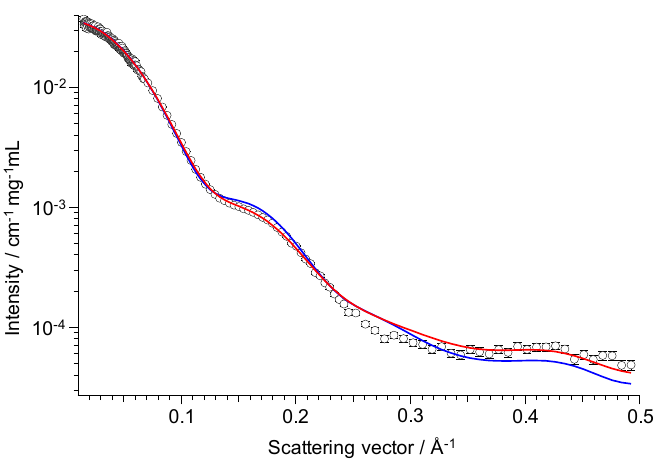
Figure 2. SAXS-based experimental validation of the MD-derived ensemble model. SAXS profile of fucosyl IgG1-Fc (open circle) shown with theoretical profiles computed from the MD-derived ensemble model (red) and the crystal structure (3AVE) (blue).